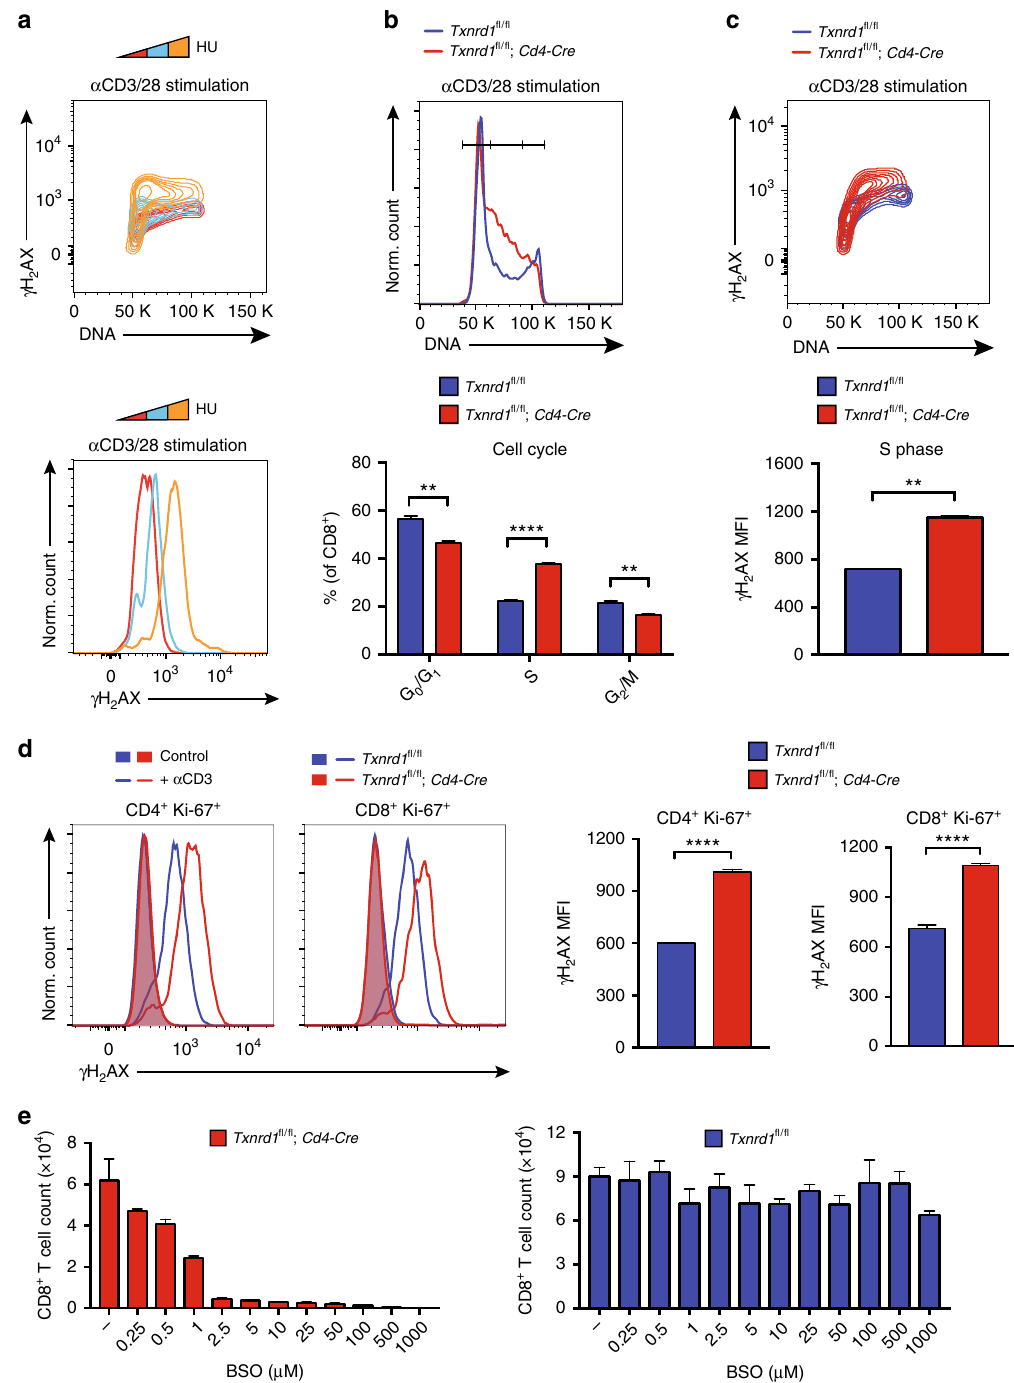
Fig. 7 Activated Txnrd1 -de fi cient T cells have an increased replication stress. a – c Magnetically sorted T cells from spleen and peripheral LNs of Txnrd1 fl / fl and Txnrd1 fl / fl ; Cd4-Cre mice were stimulated in α CD3/CD28-coated plates in vitro. Levels of the DNA damage marker γ H 2 AX and DNA content were assessed by fl ow cytometry. a CD8 + WT T cells were α CD3/28-stimulated in the presence of hydroxyurea (HU; 0, 10, 100 μ M) for 30 h before analysis. b Cell cycle analysis of CD8 + T cells with representative FACS plot with gating strategy (top; pre-gated on CD8 + ) and quanti fi cation (bottom) showing percentage of cells in the indicated cell cycle stages ( n = 3). c Representative FACS plot of CD8 + T cells (top) and MFI of γ H 2 AX in S phase cells after 30 h α CD3/28 stimulation (bottom; n = 3). d Txnrd1 fl / fl and Txnrd1 fl / fl ; Cd4-Cre mice were injected i.v. with α CD3 antibody (10 μ g), and γ H 2 AX were stained in splenic T cells 24 h after injection. Representative FACS plots (left) show γ H 2 AX expression in CD4 + Ki-67 + or CD8 + Ki-67 + T cells ( + α CD3) compared to total CD4 + or CD8 + T cells from PBS-treated mice (Control). Bar graphs on the right quantify γ H 2 AX in CD4 + Ki-67 + or CD8 + Ki-67 + T cells from α CD3- treated mice ( n = 3). e CD8 + T cells were stimulated in the presence of increasing concentrations of BSO. After 3 days of α CD3/28 stimulation, live cells were counted ( n = 4). Bar graphs show mean + standard deviation ( b – e ). Data are representative of two ( a , d , e ) and four ( b , c ) independent experiments. Student ’ s t test (two-tailed, unpaired) was used to compare Txnrd1 fl / fl and Txnrd1 fl / fl ; Cd4-Cre groups ( b – d ): ** P ≤ 0.01; **** P ≤